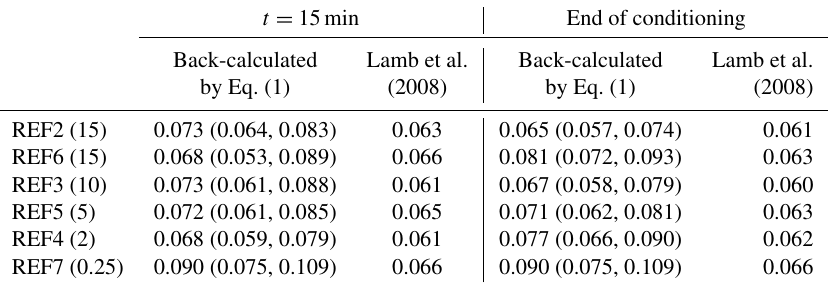
Table 2. Values of τ ∗ c at the beginning ( t = 15min) and the end of conditioning phase in each experiment. Here τ ∗ c is back-calculated with Eq. (1). Also shown here are values of τ ∗ c estimated with the equation of Lamb et al. (2008) for comparison. Values in the brackets denote the range of uncertainty associated with the τ ∗ c values back-calculated with Eq. (1). t = 15min End of conditioning Back-calculated Lamb et al. Back-calculated Lamb et al. by Eq. (1) (2008) by Eq. (1) (2008) REF2 (15) 0.073 (0.064, 0.083) 0.063 0.065 (0.057, 0.074) 0.061 REF6 (15) 0.068 (0.053, 0.089) 0.066 0.081 (0.072, 0.093) 0.063 REF3 (10) 0.073 (0.061, 0.088)